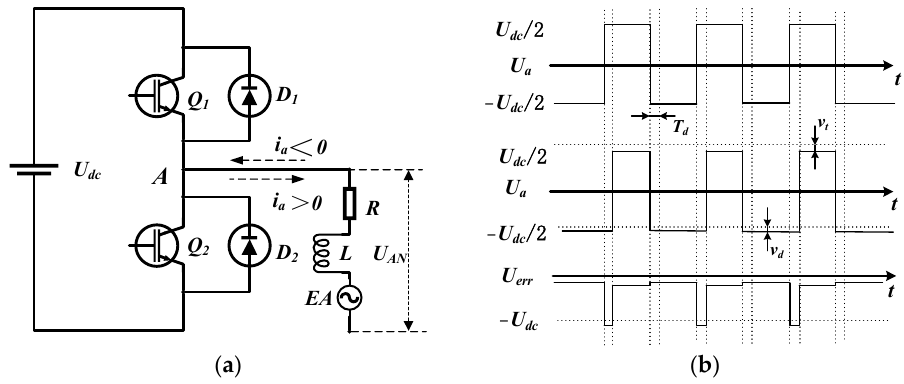
Figure 2. Inverter A-phase bridge arm circuit and output voltage waveform: ( a ) inverter A-phase bridge arm structure diagram; ( b ) waveform of A-phase bridge arm signal when i a > 0.